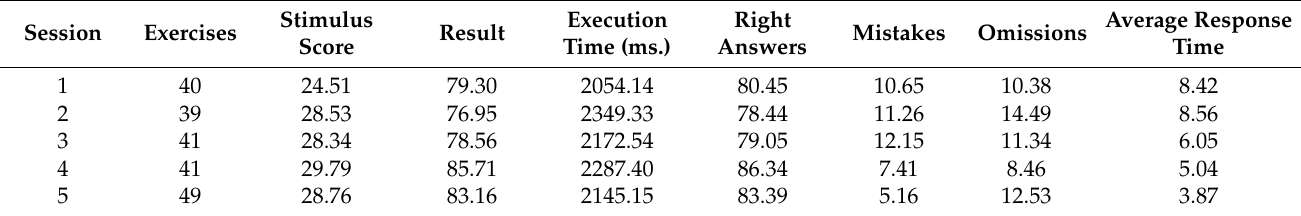
Table 3. Results of the application of the STIMULUS